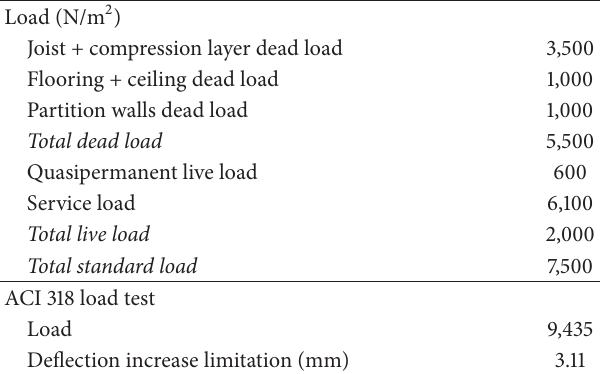
Table 1: Process of load